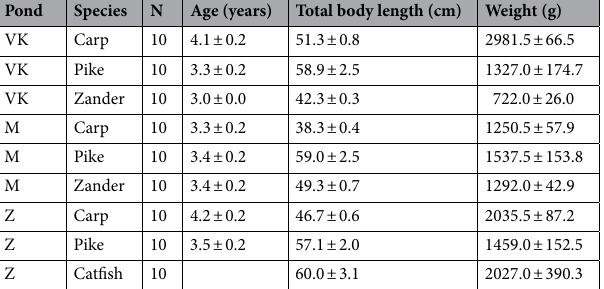
Table 1. Age, total body length and body weight of fish (mean ± standard error of mean) caught at three ponds: Velky Kocelovicky (VK), Mysliv (M) and Zehunsky